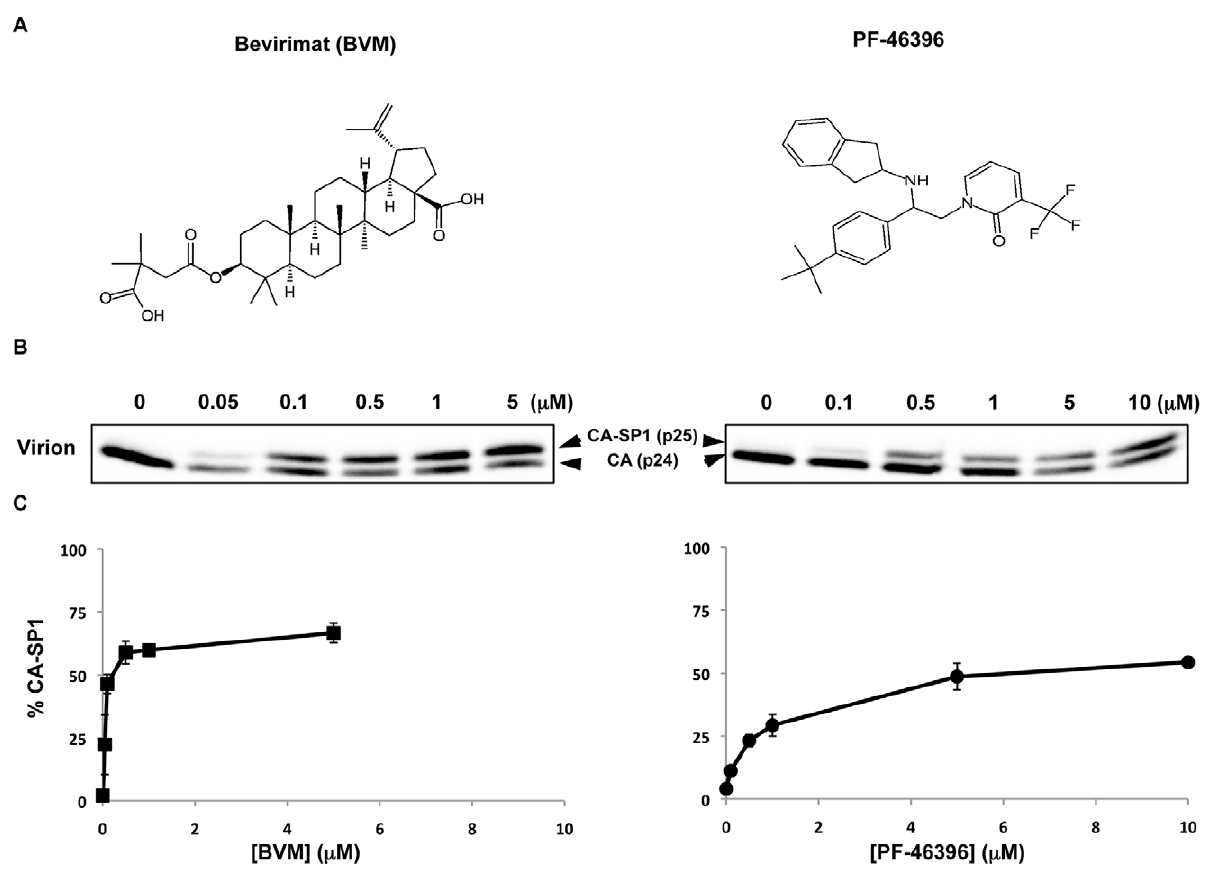
Figure 1. PF-46396 blocks CA-SP1 processing. [A] Chemical structures of BVM and PF-46396. [B] Radioimmunoprecipitation analysis of virion-associated CA and CA-SP1 in the presence of increasing concentrations of BVM or PF-46396. [C] Quantification of the % CA-SP1 relative to total CA + CA-SP1 in virion fraction at the indicated concentrations of BVM or PF-46396. Error bars indicate SD; N . 3.